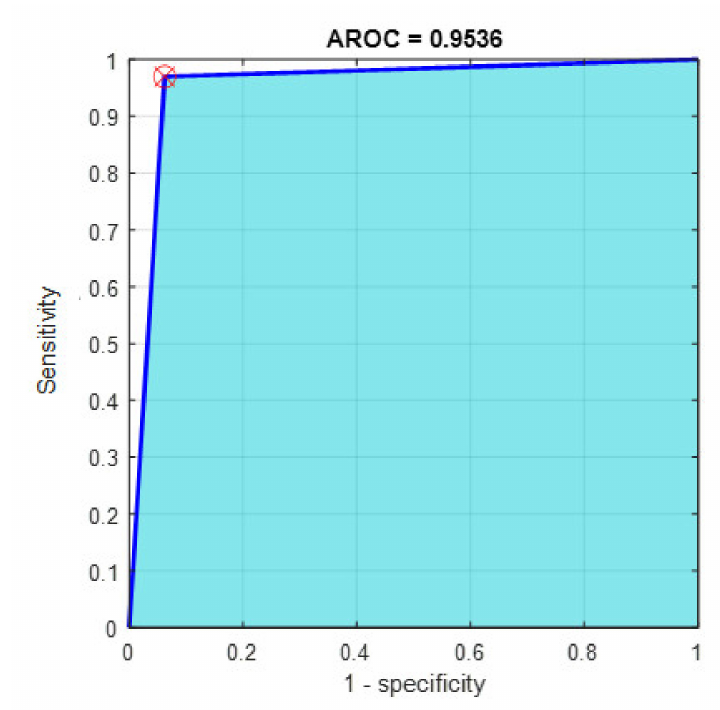
Figure 14. The AROC with ECFS-reduced features for Model 2.